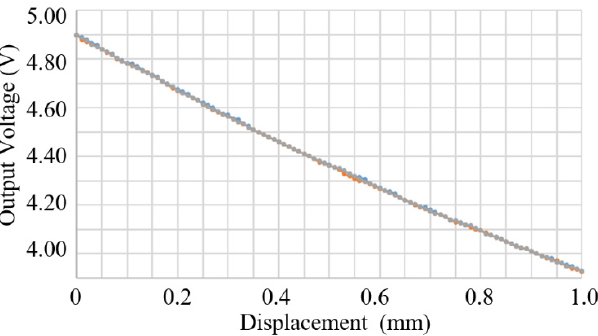
Figure 20. Output voltage of a Honeywell SS495A Hall senor in relation to the displacement of a tape magnet with respect to the sensor, three measurements relative to one arbitrarily set positon as the origin.